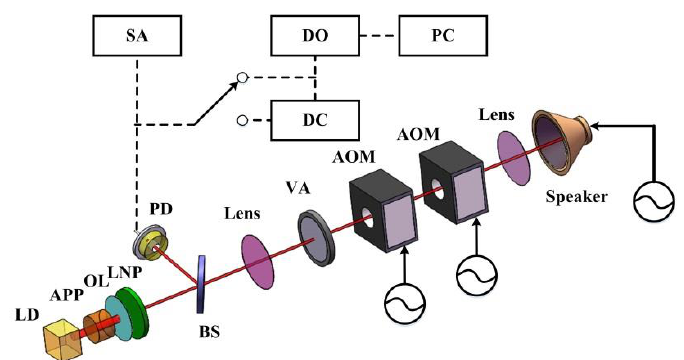
Figure 8. Experimental configuration of self-mixing laser-Doppler vibrometry. LD, laser diode; APP, anamorphic prism pairs; OL, objective microscopelens; BS, glass-plate beam splitter; PD, photodiode receiver; SA, radio frequency spectrum analyzer; VA, variable attenuator; DO, digital oscilloscope; DC, frequency demodulation circuit; PC, personal computer. (Figure reproduced from Ref. [16]).